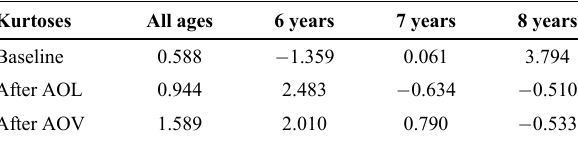
Table 1 - Kurtoses variability before and after the action observation (live and video).